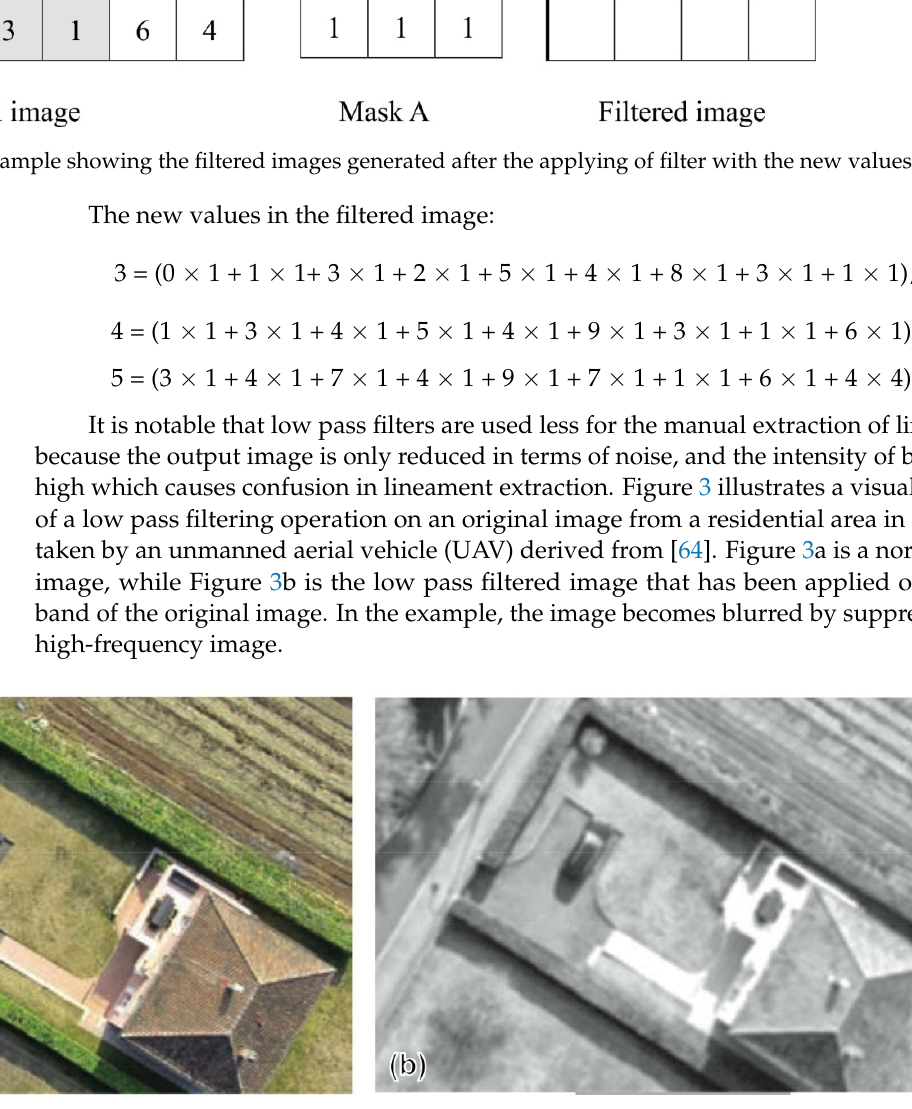
Figure 3. ( a ) original high spatial resolution image of a residential area in Germany, ( b ) Low pass filter applied to the red band. Images modified from [64].